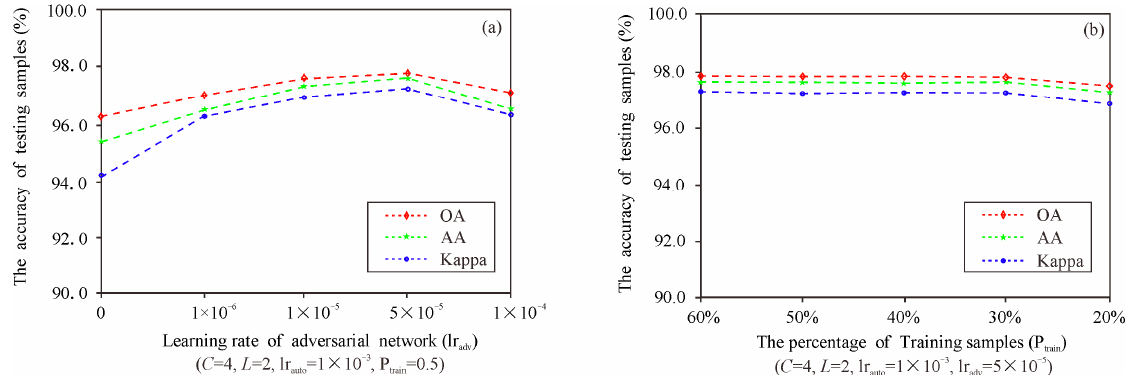
Figure 7. The performance of SSAAE with different learning rates of adversarial network and training samples, where lr Adv = 0 represents without the adversarial process. ( a ) Impact of adversarial network on classification accuracy; ( b ) impact of the percentage of training samples on classification accuracy.